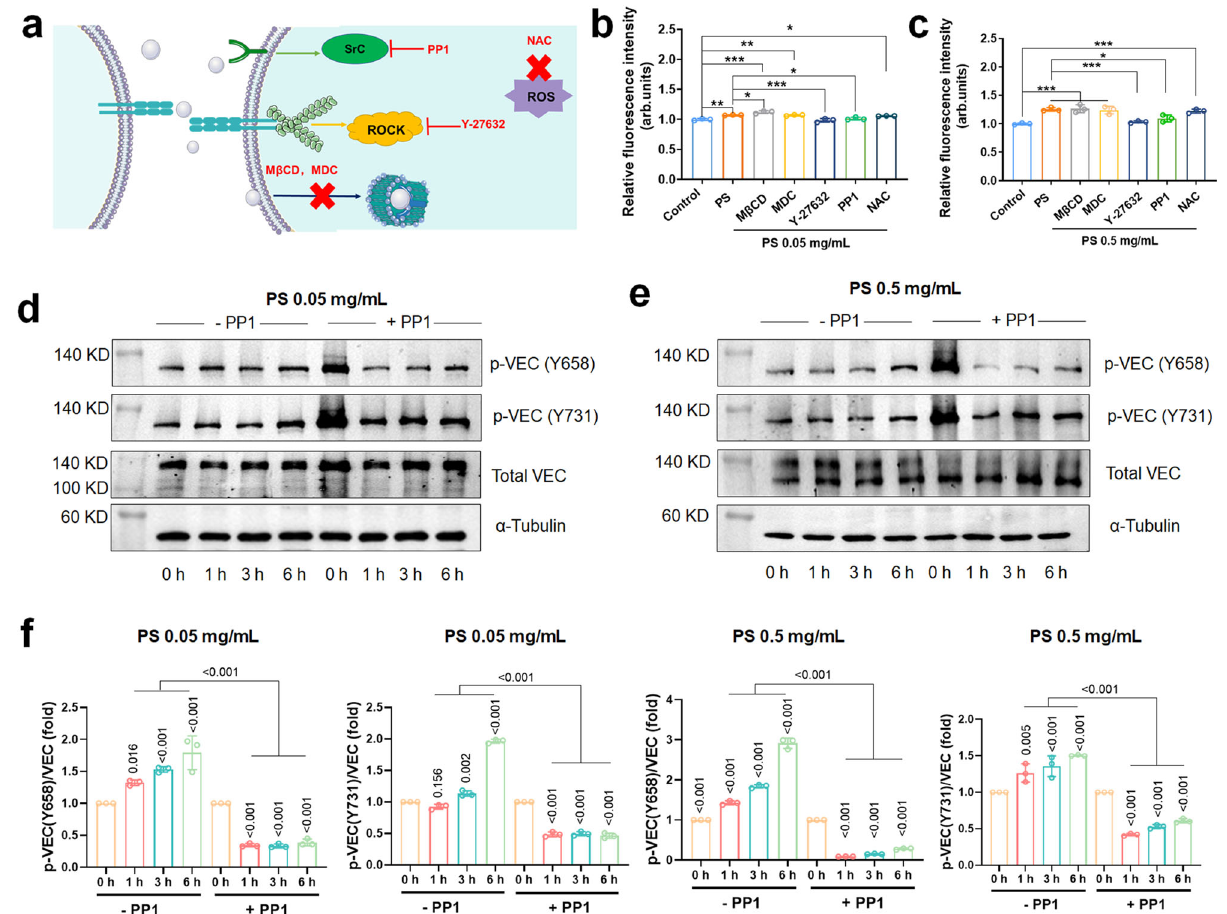
Fig. 4 | Polystyrene nanoplastic-induced endothelial leakiness is independent of ROS formation and endocytosis but is related to VE-cadherin signaling pathway and actin remodeling. a Blocking endocytosis with inhibitors or ROS inhibitiondidnotpreventleakinessofPSnanoplastic.However,Srckinaseinhibitor PP1 and ROCK inhibitor Y-27632 affected the leakiness of PS nanoplastic. HUVECs were treated with Src kinase inhibitor PP1 (10 µ M), rho-associated protein kinase (ROCK) inhibitor Y-27632 (10 µ M), endocytosis inhibitors (5mM methyl- β - cyclodextrin(M β CD)and10 µ Mmonodansylcadaverine(MDC)),orROSinhibitor(5 mM N-Acetyl-L-cysteine (NAC)) for 1h prior to b 0.05mg/mL or c 0.5mg/mL PS nanoplastic treatment. PP1 and Y-27632 signi fi cantly reduced the fold of FITC- dextran penetration compared to their respective counterparts without inhibitor treatments. M β CD, MDC, or NAC did not signi fi cantly decrease the fold of FITC- dextran penetration compared to their respective counterparts without inhibitor